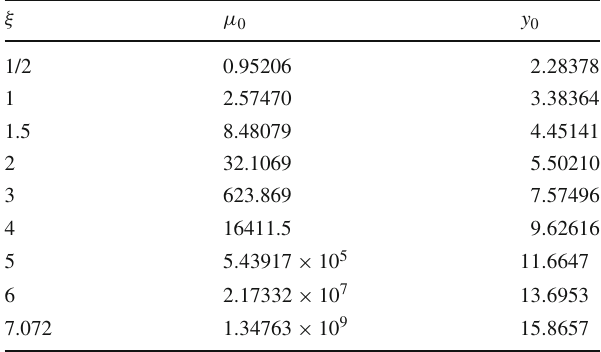
Table 1 Numerical values for the degenerate horizon y 0 = ( r 0 / h ) 1 /ξ and the corresponding extremal mass μ 0 for different values of the Einasto parameter. The case ξ = 7 . 072 corresponds to the DM case